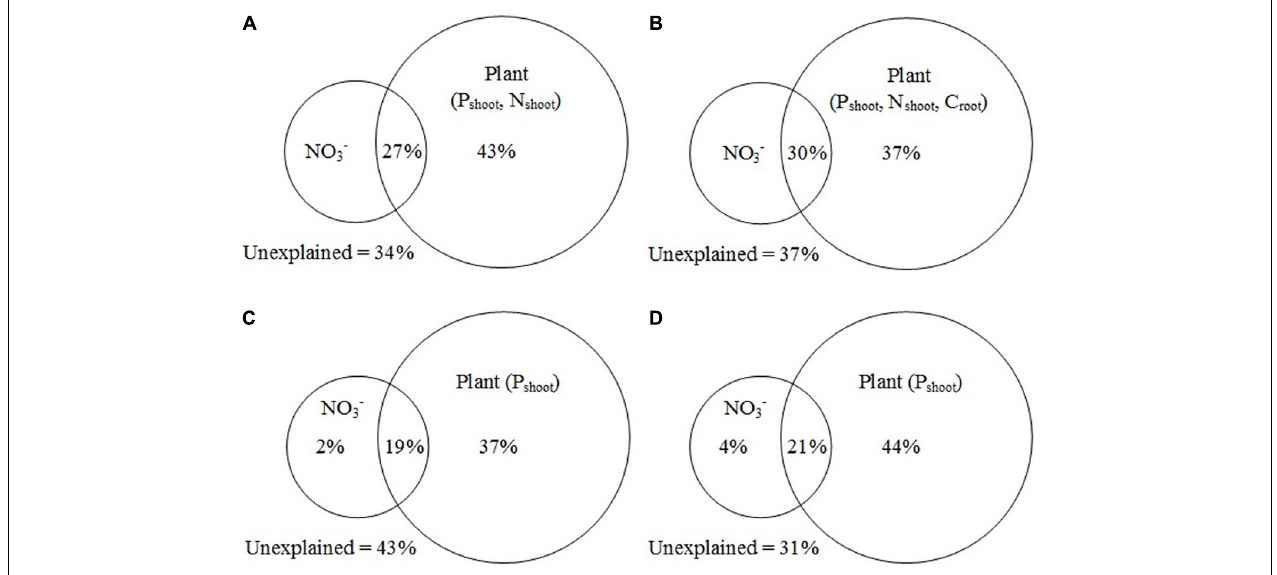
FIGURE 8 | Variation partitioning analysis (VPA) of all functional genes (A) , C cycling genes (B) , N cycling genes (C) , and P cycling genes (D) explained by soil and plant variables. N shoot , N concentration of plant shoot; P shoot , P concentration of plant shoot; C root , C concentration of plant